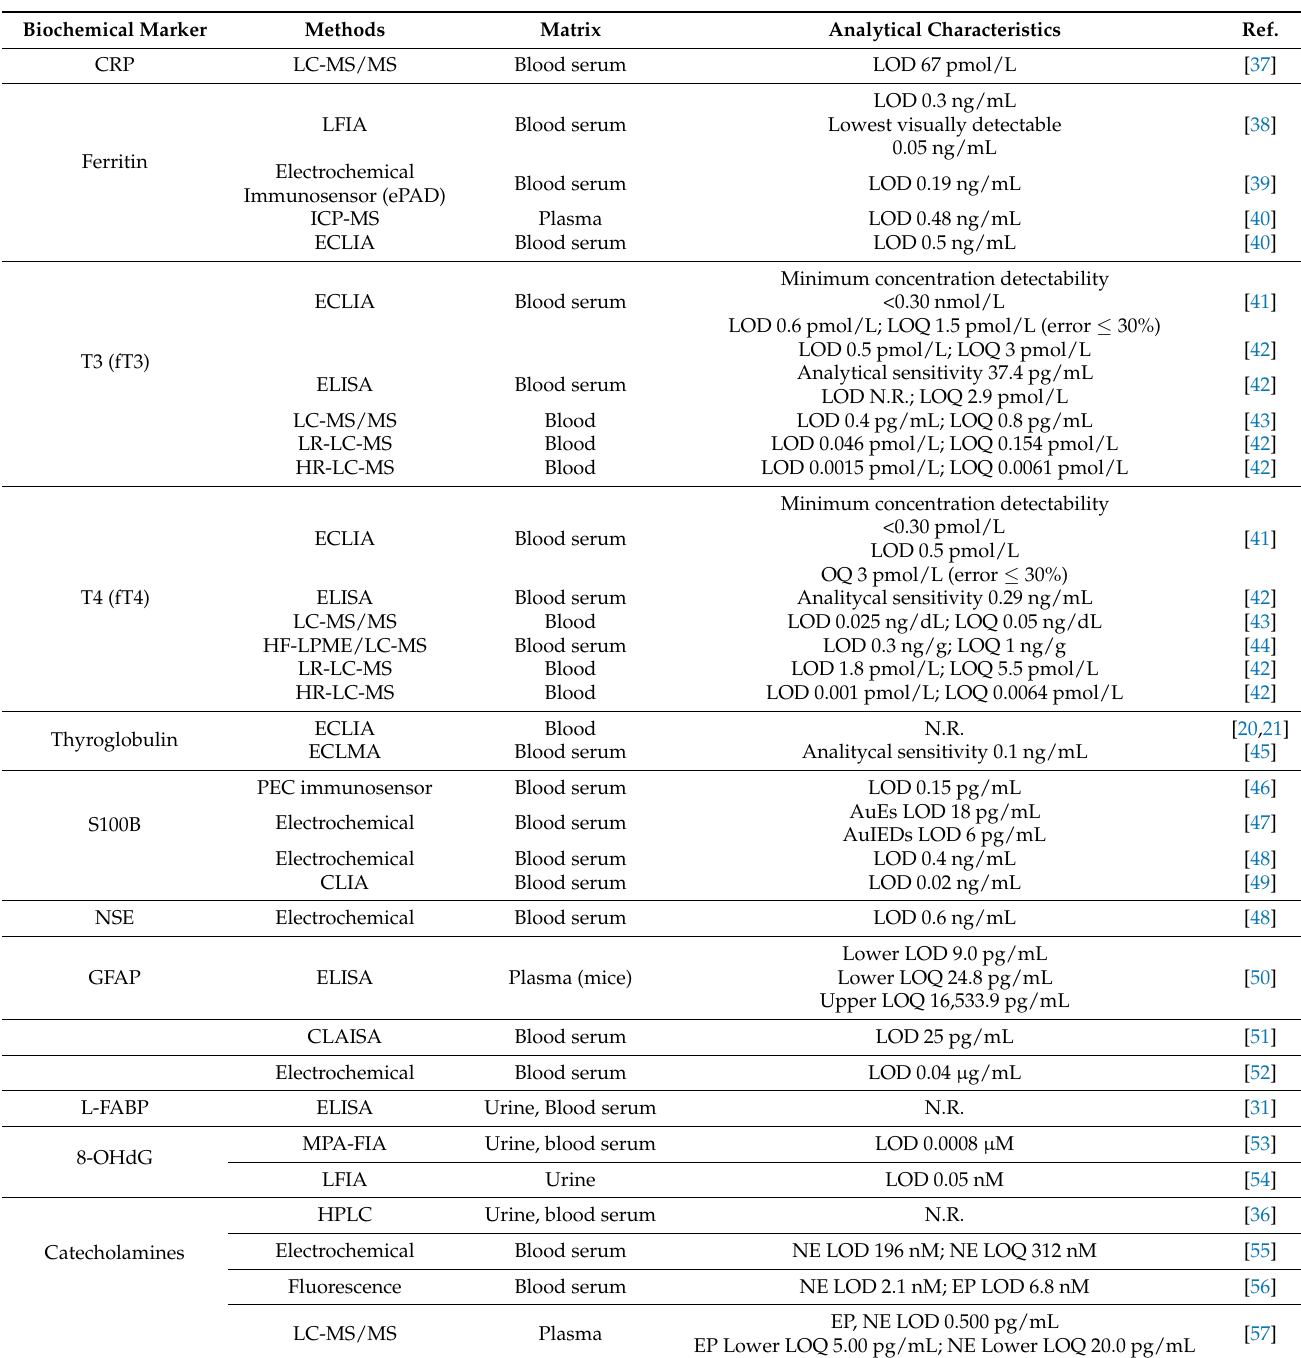
Table 2. Recently applied procedures for biochemical markers evaluation.